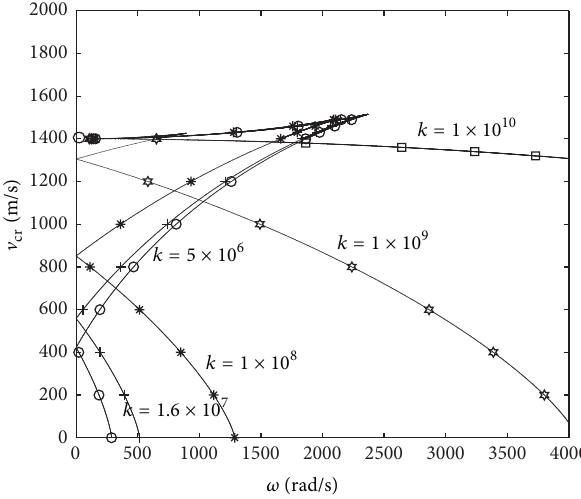
Figure 7: Critical velocity V different foundation stiffness 𝑘 ( N / m 2 )